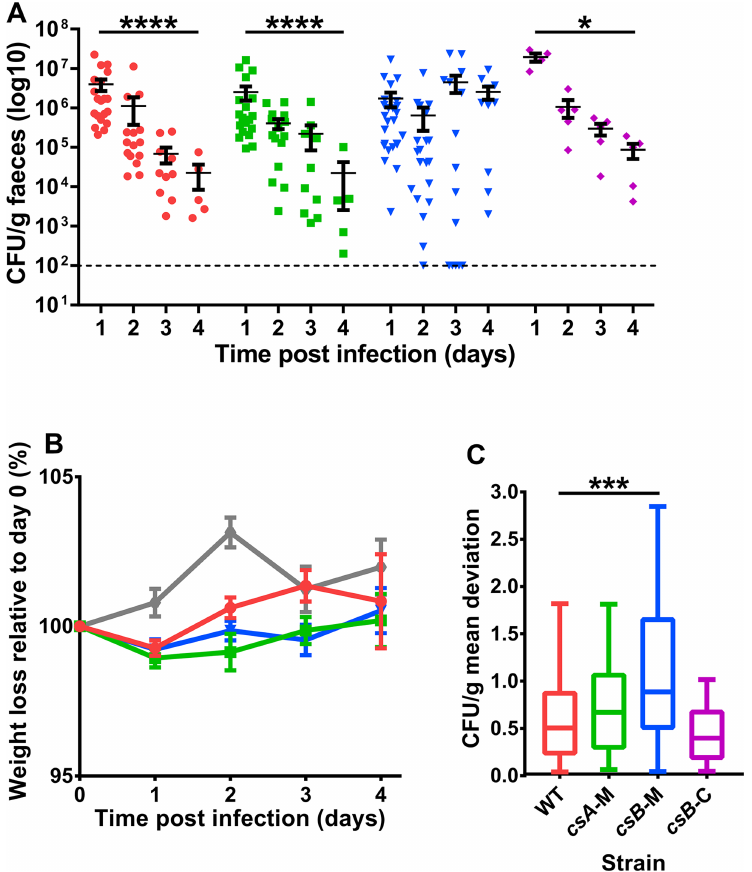
Fig 6. The csB mutant shows increased colonisation in a mouse model of gastrointestinal tract infection, but no difference in weight loss, compared to the wild-type strain. Mice orally infected with spores from the csB mutant show high levels of spores shed from the gastrointestinal tract for the duration of the experiment (A). Mice were administered either wild-type (red circle), csA mutant (green square), csB mutant (blue arrowhead) or csB complemented (purple diamond) spores. Faecal spore load was determined for each mouse every day until 4 days post infection and is presented here with each point representing a single mouse. The results represent the average of at least four mice and error bars represent standard error of the mean. The limit of detection is shown as a dashed line (A). Mice administered wild-type spores (red) showed no difference in weight loss compared to mice administered csA (green) or csB (blue) spores or to uninfected mice (grey). The results represent the average of at least five mice and error bars represent standard error of the mean (B). The variability in faecal spore load between mice administered with the same strain was calculated by determining the deviation in faecal spore load of each mouse in comparison to the mean faecal spore load of mice administered with the same strain and is presented here as box plots with Tukey whiskers (C). Asterisks indicate statistical difference at (cid:3) , p (cid:20) 0.05; (cid:3)(cid:3) , p (cid:20) 0.01; (cid:3)(cid:3)(cid:3)(cid:3) , p (cid:20) 0.0001. Wild-type, WT; csA mutant, csA -M; csB mutant, csB -M; csB mutant complemented, csB